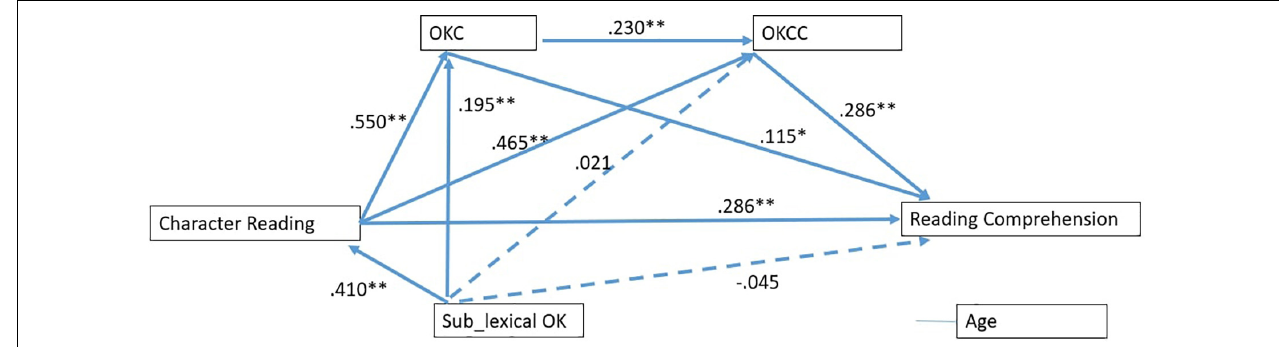
FIGURE 1 | Path model demonstrating relationship between character reading and reading comprehension. ** p < 0.01, * p < 0.05, Sub-lexical OK, Sub-lexical orthographic knowledge; OKC, Orthographic choice; OKCC, Orthographic choice in context. Coefficients for the controlled variable age were not shown for